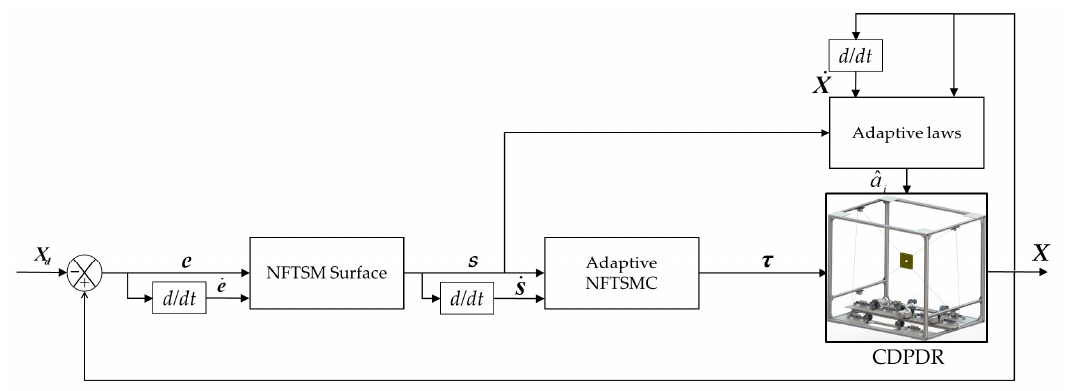
Figure 7. Control flowchart of the proposed controller.